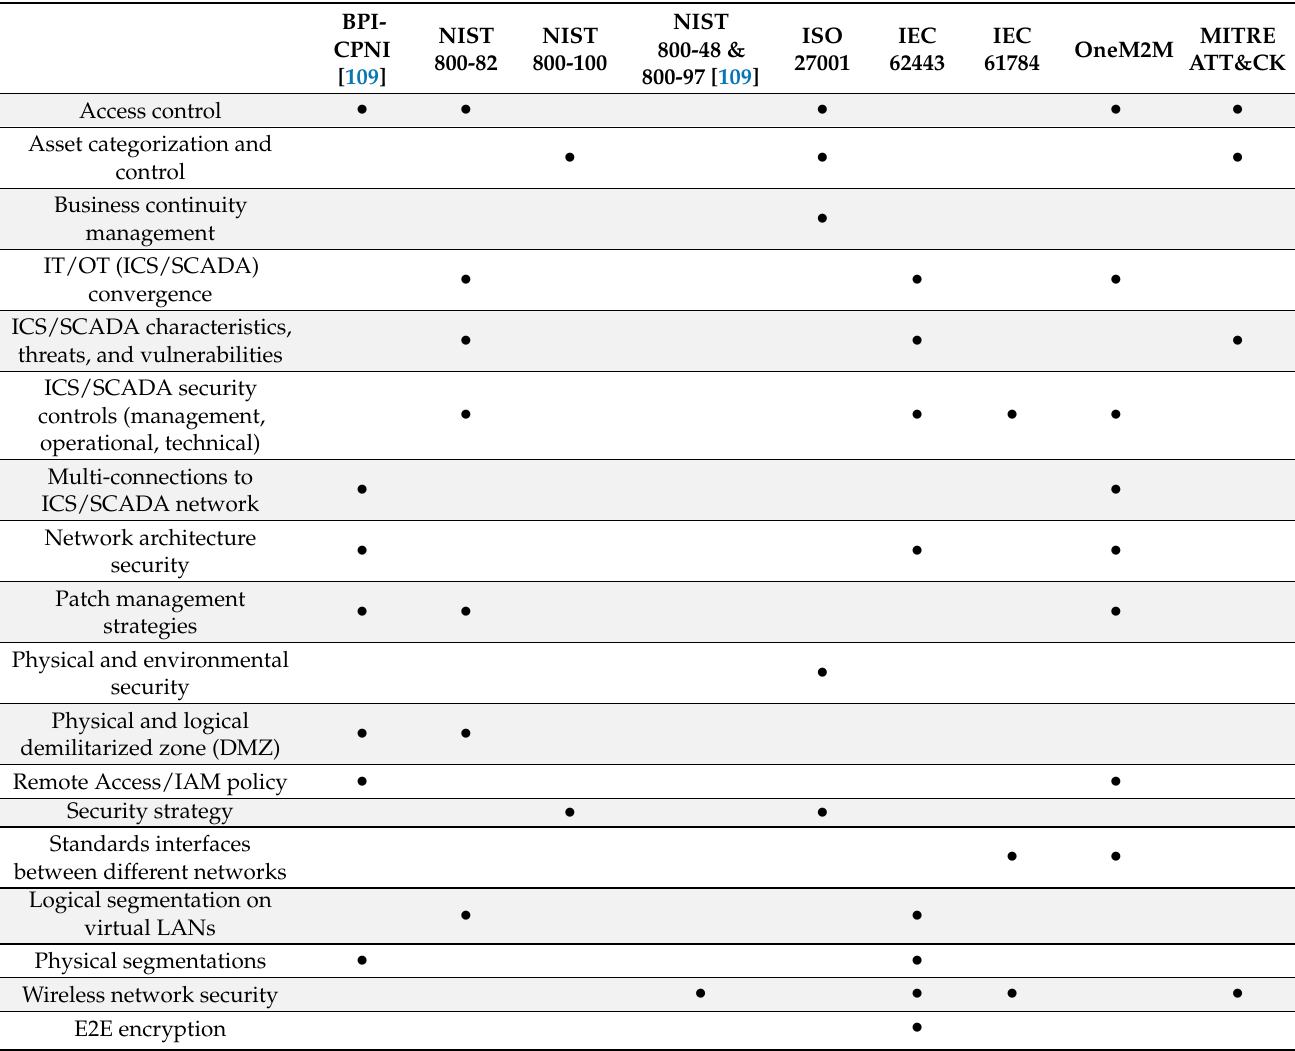
Table 6. Various standards illustrating different aspects of ICS/SCADA security